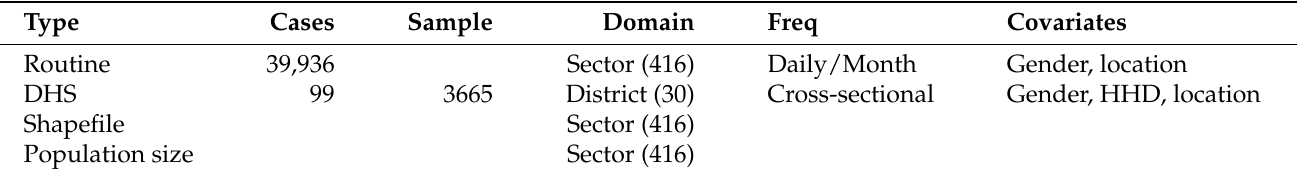
Table 1. Datasets used for children under five years